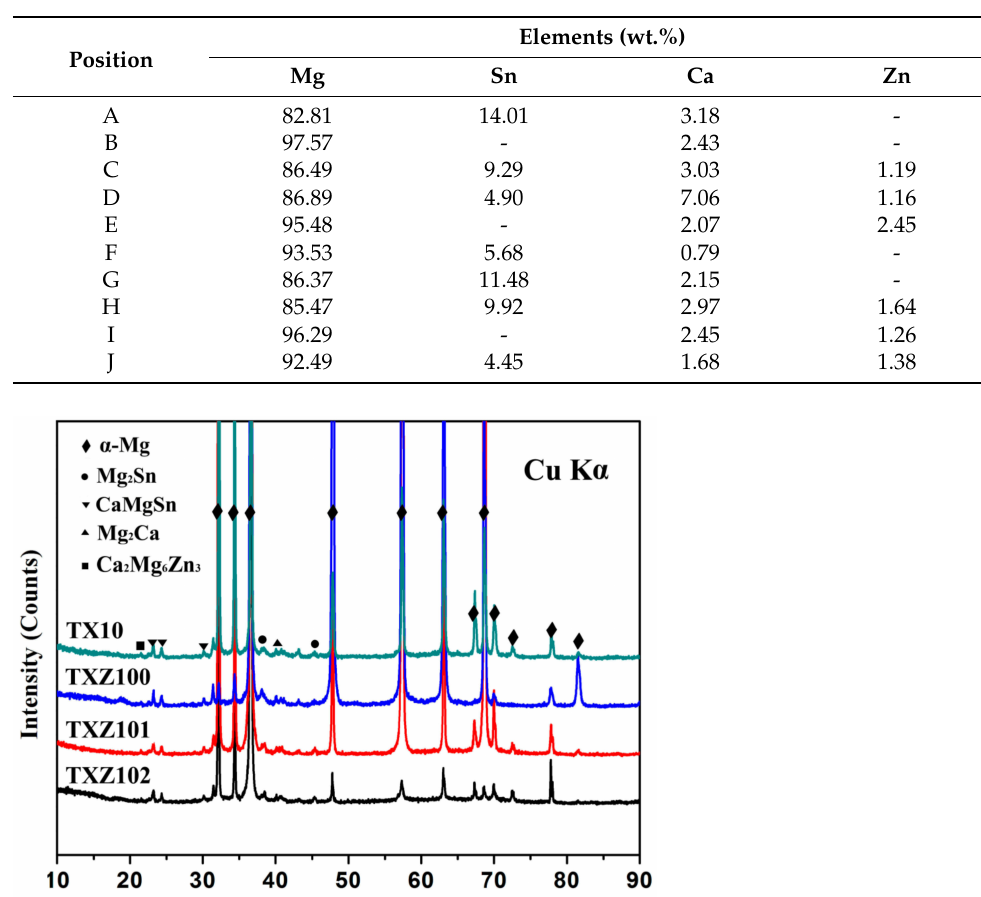
Table 2. EDS results of the Mg-1.0Sn-0.5Ca-xZn alloys in Figure 1 (wt.%).